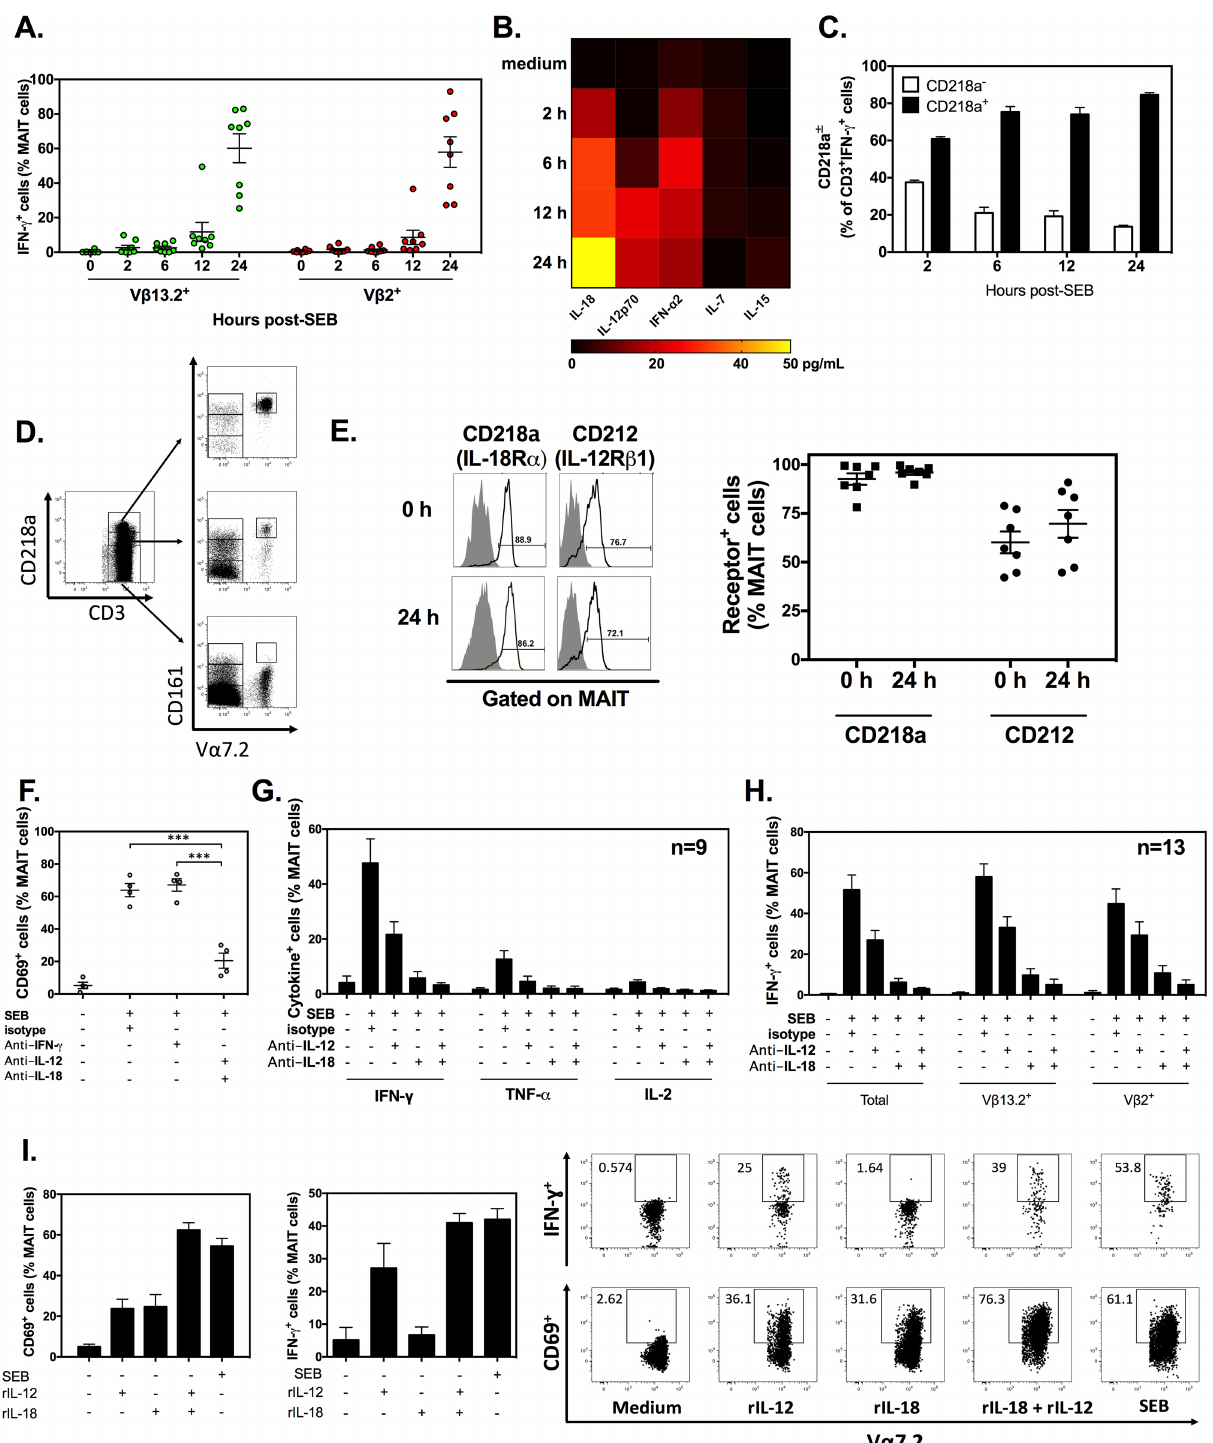
Fig 6. Staphylococcal enterotoxin B (SEB) can activatehuman mucosa-associated invariant T (MAIT) cells by an interleukin (IL)-12/ IL-18-dependent mechanism. Peripheral blood mononuclear cells (PBMCs) were exposedto SEB for 24 h, and interferon(IFN)- γ + events were enumerated amongV β 13.2 + and V β 2 + MAIT cells ( A ). Human PBMCs ( n = 4) were stimulatedwith SEB before culture supernatants were harvestedat indicatedtime points to assay for IL-18, IL-12p70, IFN- α 2, IL-7, and IL-15. Data were averagedto generatea heat map ( B ). The relative frequencies of CD218a + and CD218a - cells within the CD3 + IFN- γ + gate was determinedat indicatedtime points post-SEB